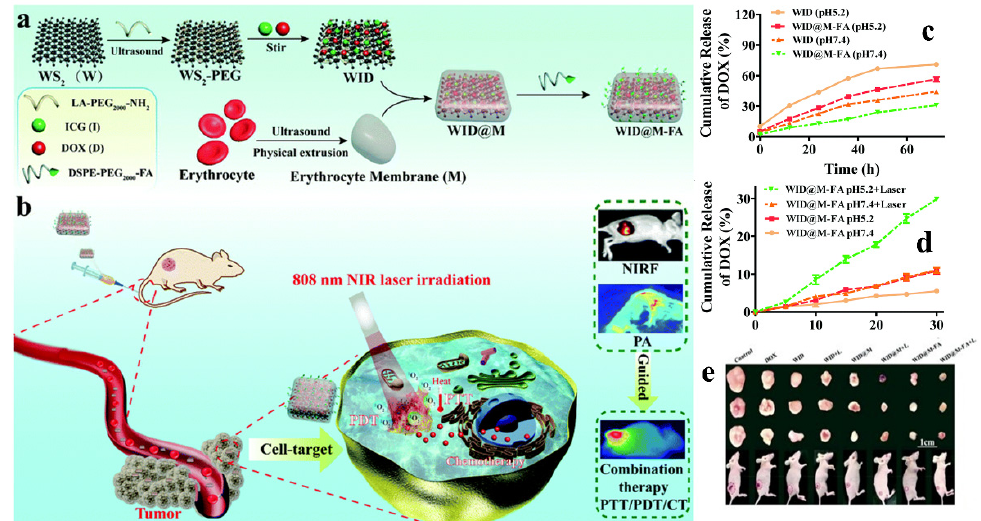
Figure 9. Schematic illustration depicting ( a ) the synthesis and preparation method of multifunctional RBC and LA-PEG membrane-coated FA-functionalized NSs and ( b ) synergistic drug release behavior of CTX/PTT; ( c ) DOX release curve with and without FA functionalization on NSs at pH 7.4 and 5.2; ( d ) DOX release profile with or without NIR laser irradiation; ( e ) digital photographs of tumor tissues from each group after 18 days’ treatment (adapted from Reference [63], Biomaterials Science, published by The Royal Society of Chemistry, 2020).